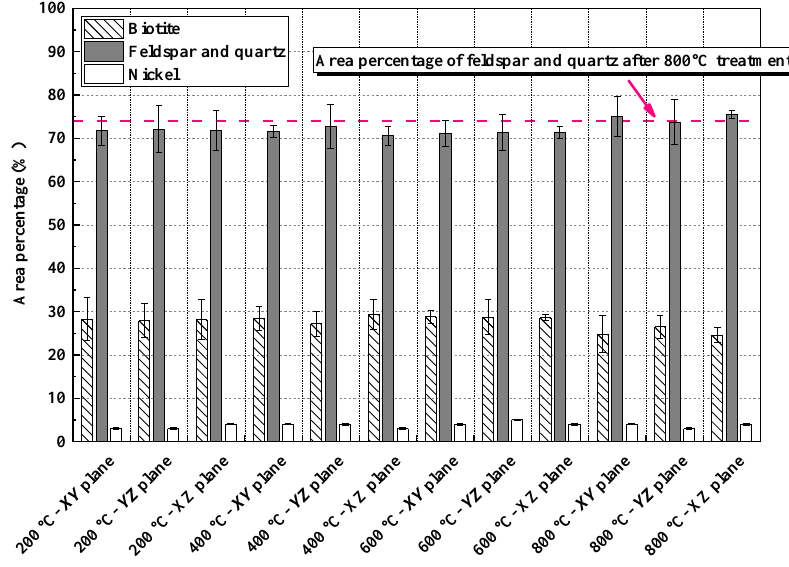
Figure 7. Area percentage of different minerals.